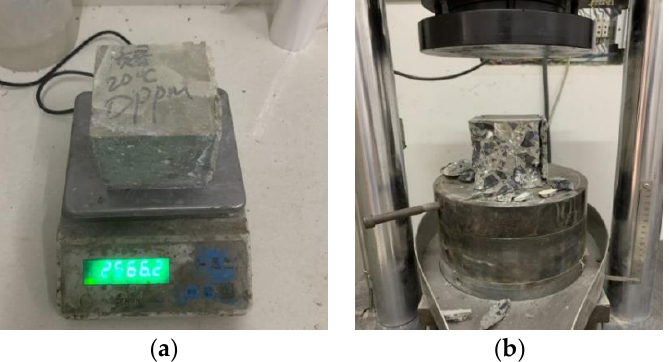
Figure 2. Mass compressive strength test on concrete. ( a ) electronic scaleand ( b ) electronic universal-testing machine.